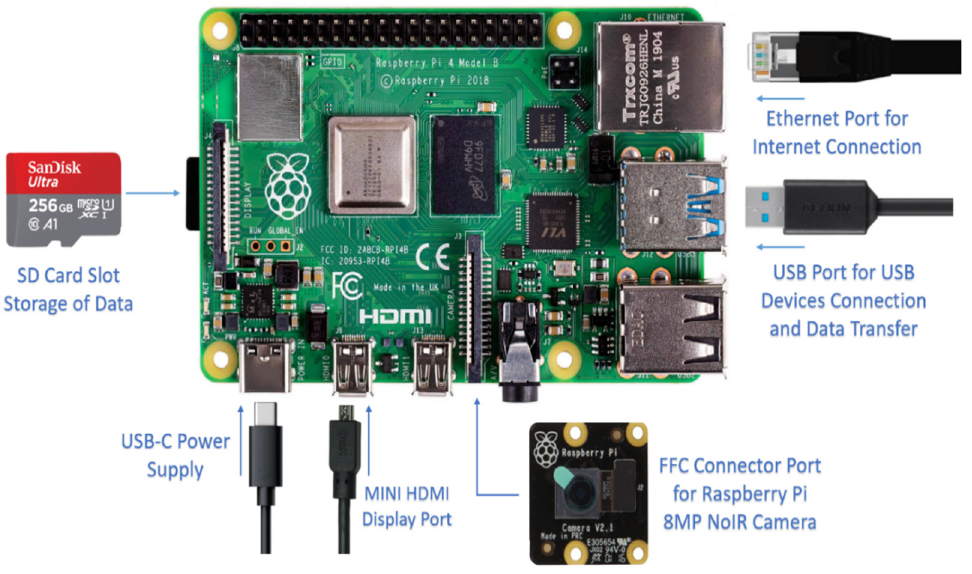
Figure 3. The setup of the Raspberry Pi 4B for live video monitoring and image capturing system.